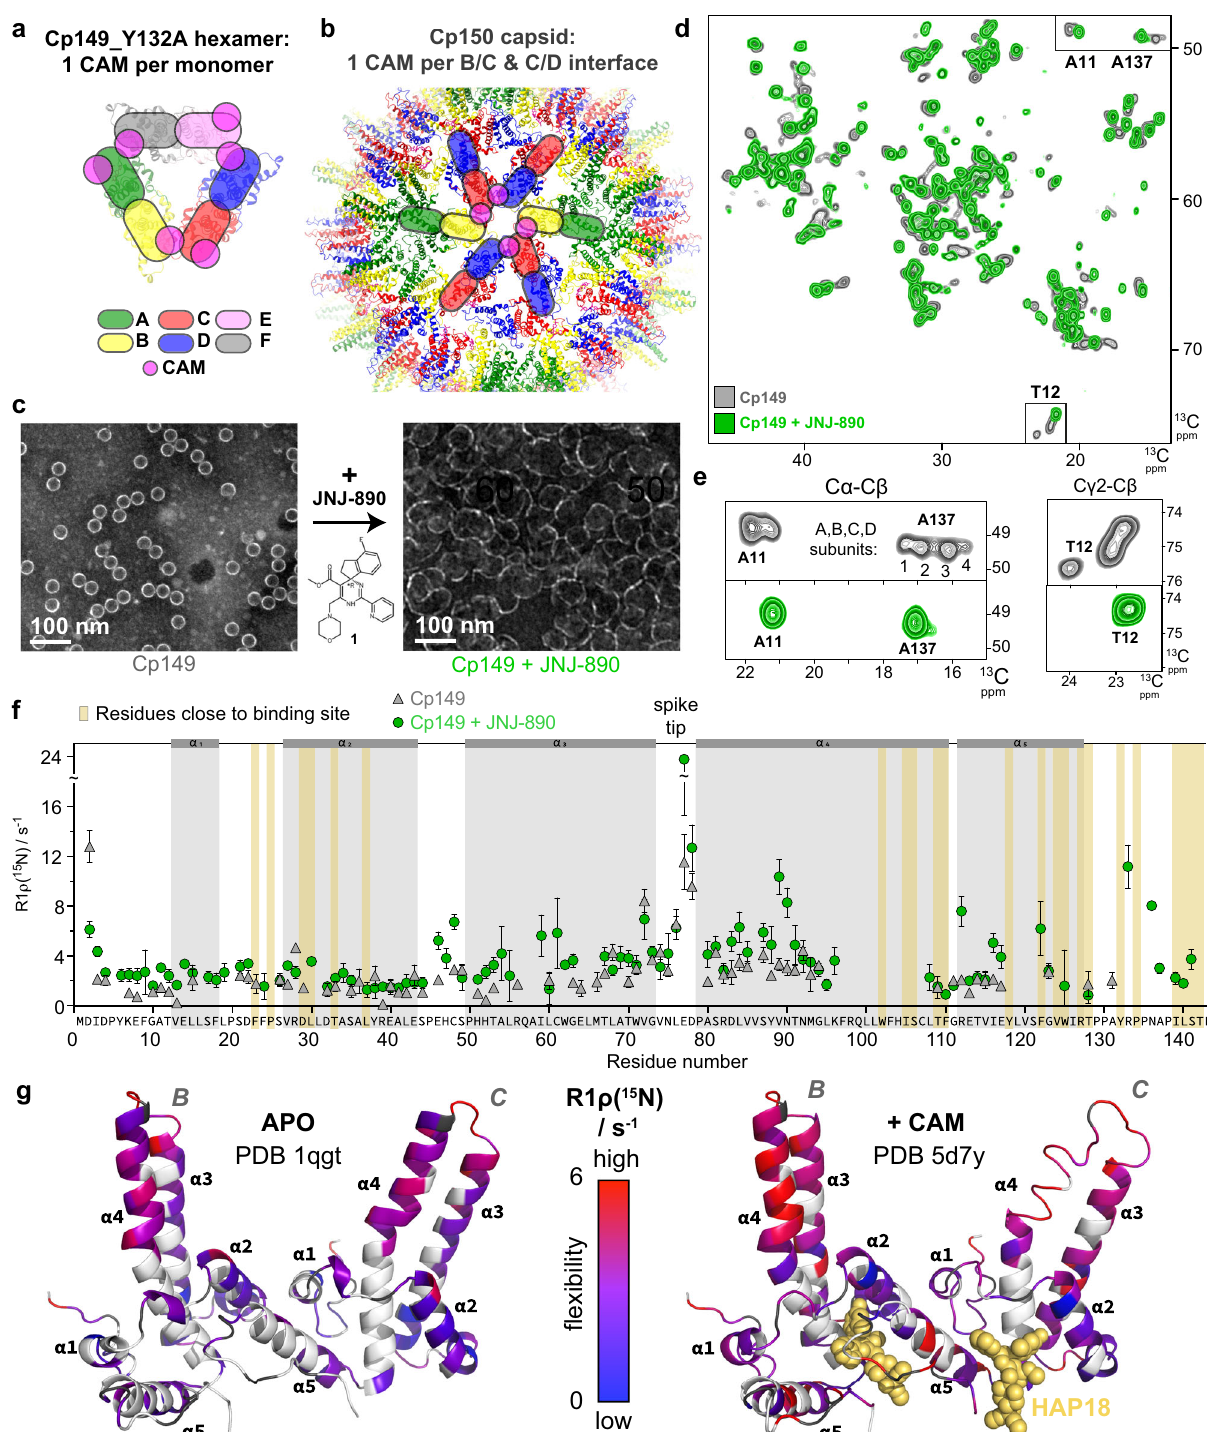
without CAM-A (in gray). The spectra surprisingly demonstrate that the aberrant objects induced by the CAM-A compound actually yield well-resolved resonance lines inthe solid-state NMR spectra, with lines which are even narrower than in the absence of CAMs. Of note, whe- ther CAMs were added to Cp149 preassembled capsids, or to Cp149 dimers before capsid assembly, made no difference for the resulting spectra (Supplementary Fig. 2), as also observed by EM 48 . Sequential resonance assignments using 3D NMR following previously described protocols 49,50 revealed only a single peak per atom for the CAM-A capsid spectra, while we previously described for the apo form